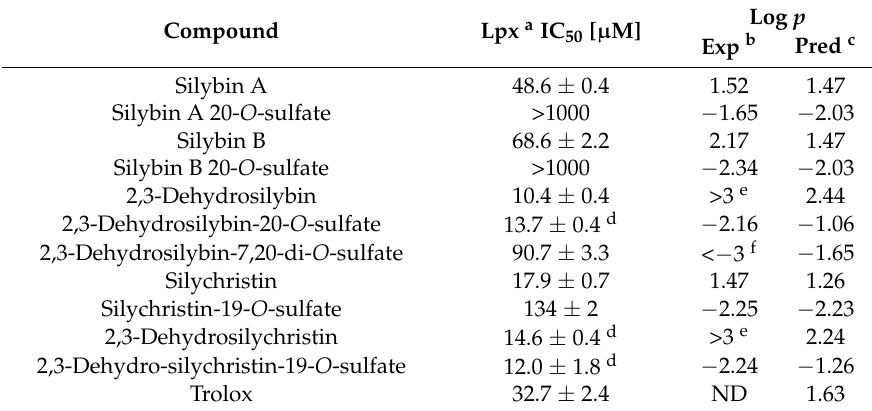
Table 4. Anti-lipoperoxidant capacity and lipophilicity of flavonolignan sulfates in comparison with non-conjugated